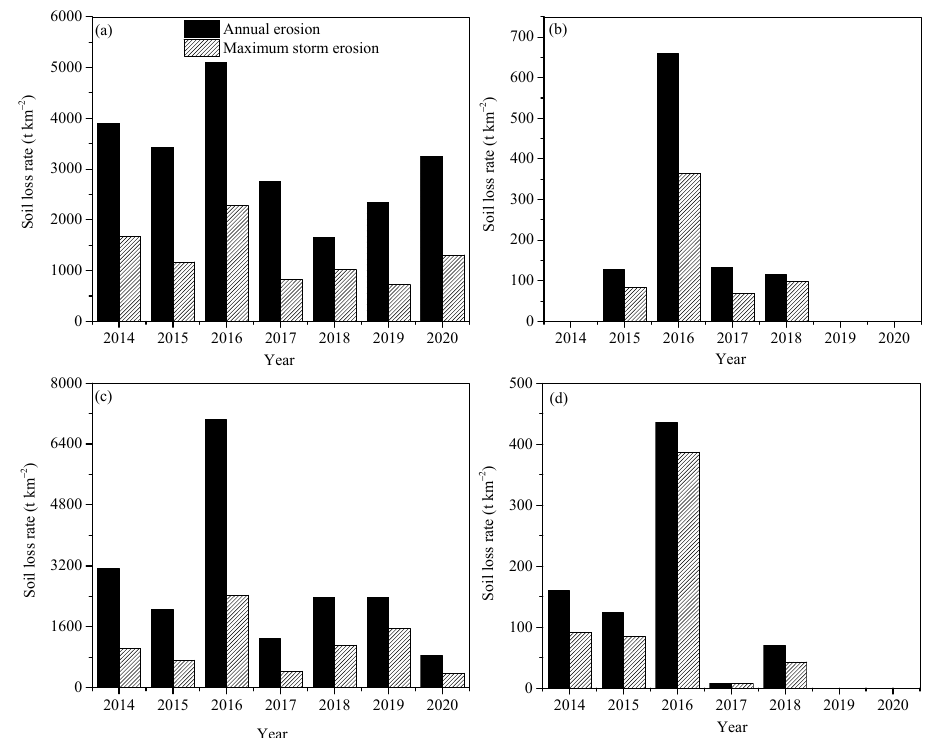
Figure 7. Soil loss in the maximum annual erosive event and annual soil loss on four types of land use and soil conservation measures: plot 1 ( a ), plot 2 ( b ), plot 3 ( c ), and plot 14 ( d ). The information of the plots was given in Table 1.